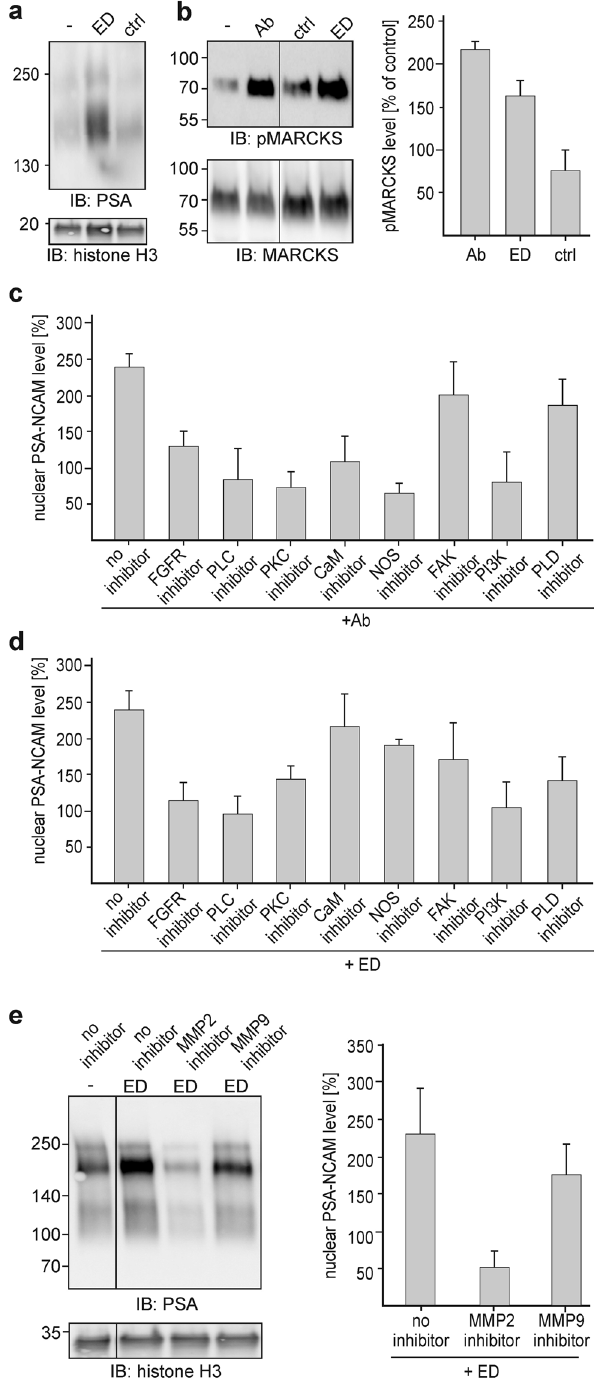
Figure 4. NCAM antibody and the MARCKS-derived ED peptide trigger the generation and nuclear import of PSA-NCAM by different pathways. ( a – e ) Cerebellar neurons were treated without ( − ) ( a , b , e ) or with chicken NCAM antibody (12.5 µ g/ml IgY) (Ab) ( b , c ), ED peptide (25 µ g/ml) (ED) ( a , b , d , e ) or ED control peptide (25 µ g/ml) (ctrl) ( a , b ). ( a ) Nuclear fractions were isolated and subjected to immunoblot analysis with PSA antibody or with histone H3 antibody to control loading. ( b ) Cell lysates were probed by immunoblot analysis with an antibody against phosphorylated MARCKS (pMARCKS) or total MARCKS. Levels of phosphorylated MARCKS were quantified by densitometry and normalized to the levels of total MARCKS. Mean values with standard deviation from 3 independent experiments are shown for the levels of phosphorylated MARCKS in treated neurons relative to the levels in non-treated cells (set to 100%). ( c , d ) Cerebellar neurons were pretreated without (no inhibitor) or with inhibitors of FGF receptor (100 nM), calmodulin (10 µ M), PLC (10 µ M), PKC (1.5 µ M), NOS (100 µ M), FAK (10 µ M), PLD (40 nM) or PI3K (4 µ M) and then treated without ( − ) or with chicken NCAM antibody (12.5 µ g/ml IgY) (Ab) ( c ) or ED peptide (25 µ g/ml) (ED) ( d ) or were